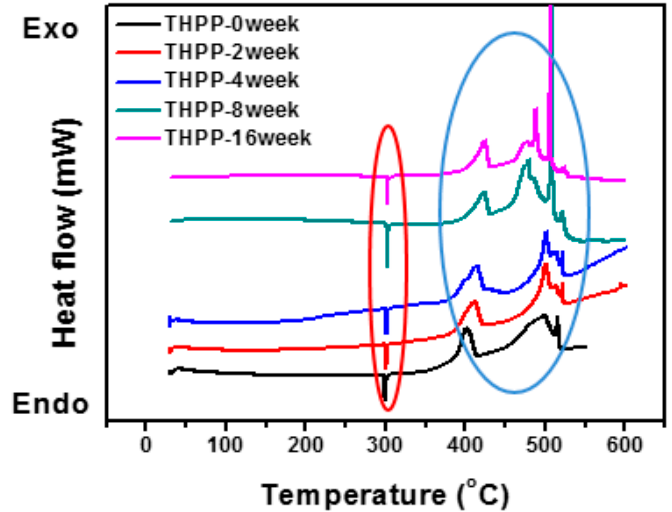
Figure 2. DSC profiles of THPP under accelerated aging conditions. The relative heat released rarely changed with the duration of accelerated aging.